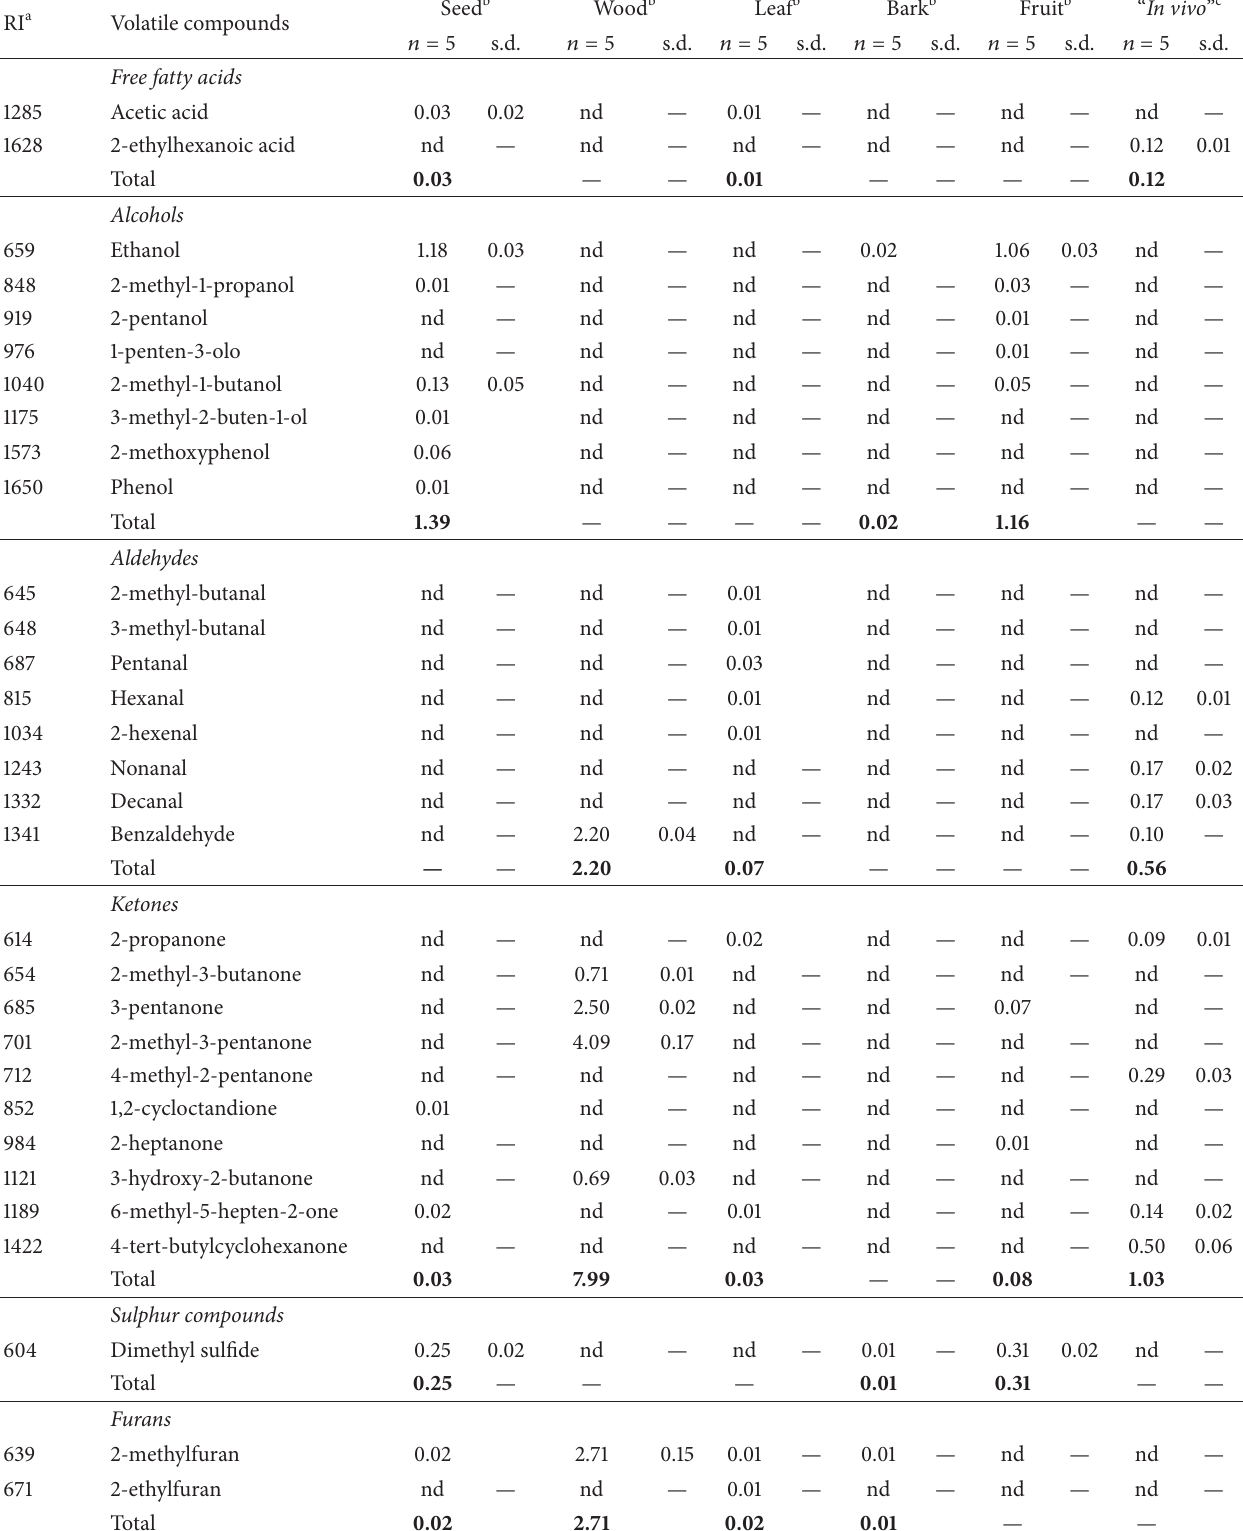
Table 4: Identification of volatile organic compounds (VOCs) by HS-SME-GC/MS from headspace of B. orellana plant extracts obtained from different plant parts and from the headspace in living plant fruits ( in vivo sampling). RI